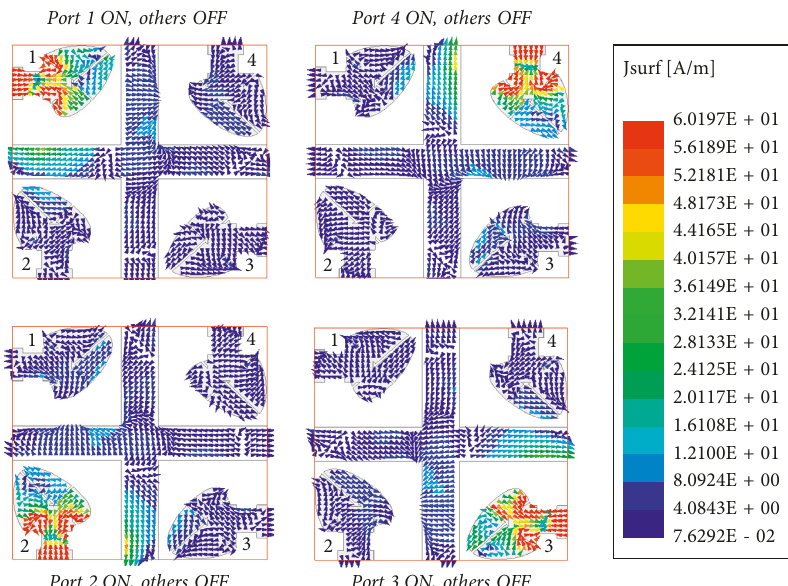
Figure 13: Simulated surface current distribution on the MIMO configuration with decoupling lines.